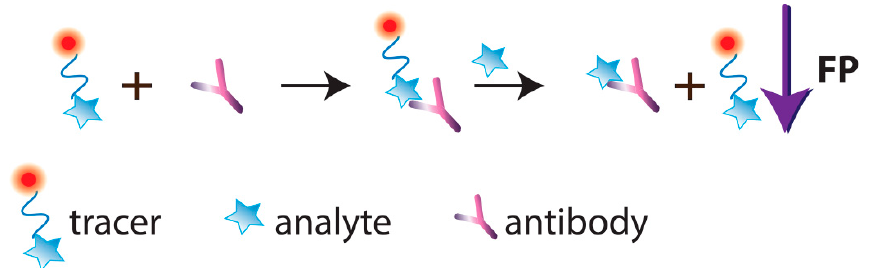
Figure 4. Schematic illustration of single-reagent FPIA.